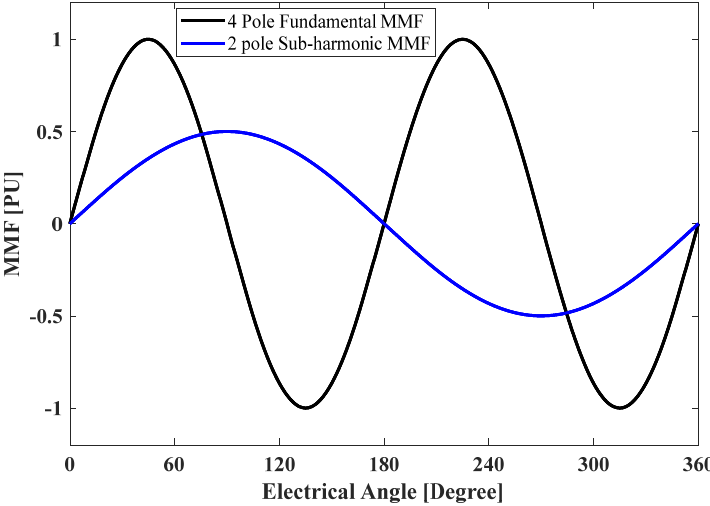
Figure 4. Fundamental and subharmonic components of MMF.